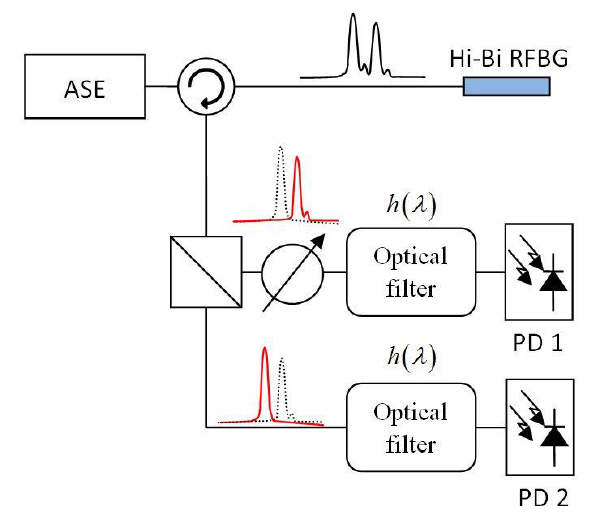
Figure 3. Proposed interrogation setup. ASE stands for Amplified Spontaneous Emission and PD for